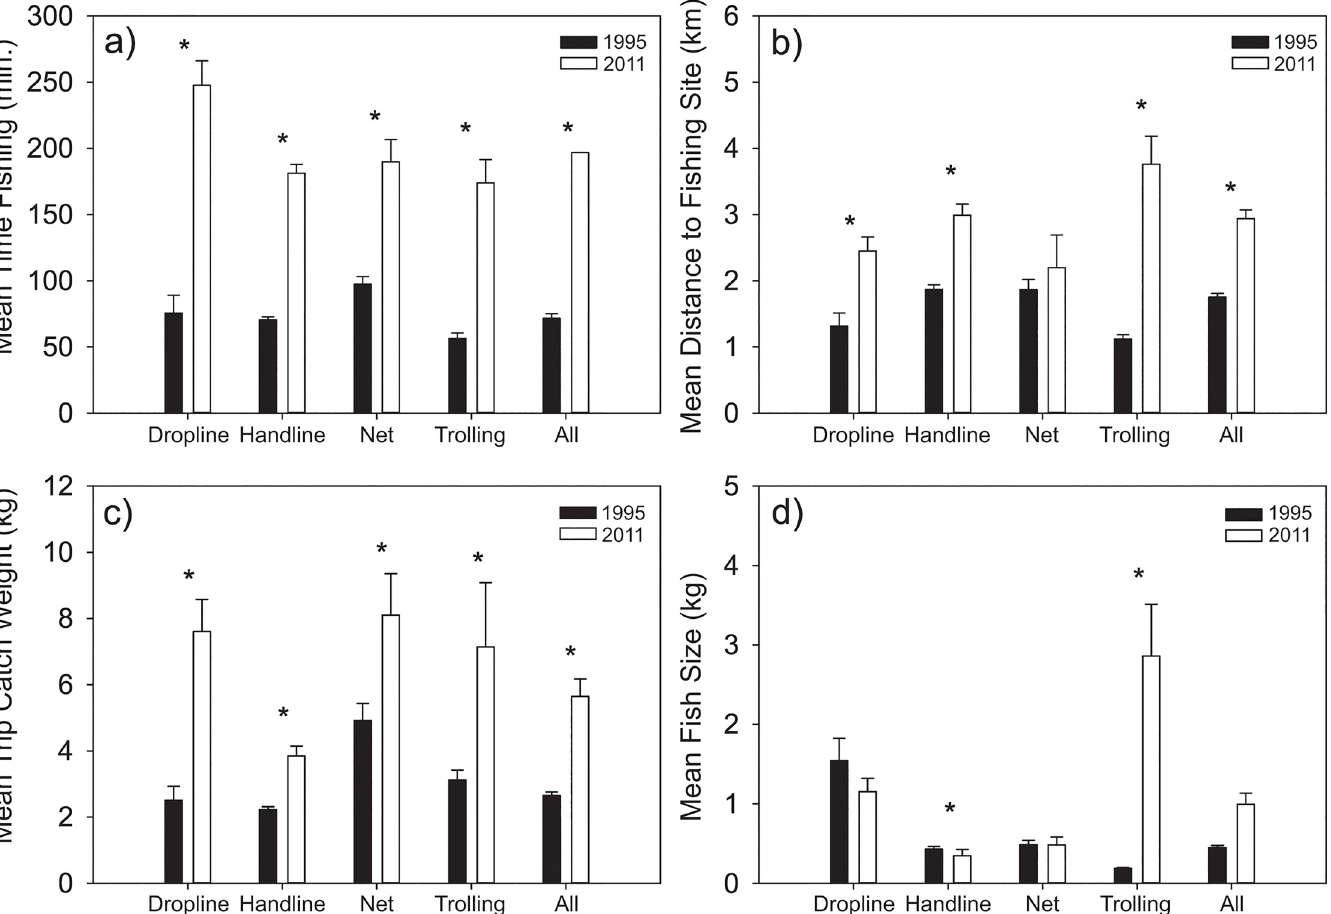
Fig 1. Catch parameters for the Roviana lagoon study area for data collected in 1995 and 2011. Panels show a) Mean time spent fishing in 1995 and 2011, b) mean distance to fishing site, c) mean fishing trip catch weight, d) mean fish size. Data significantly different between 1995 and 2011 using a Kruskal-Wallis test are shown ( * ). Statistical results for all fishing methods are shown in results section. Statistical results for individual methods are shown within S1